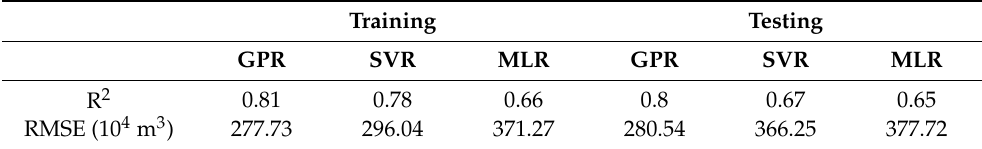
Table 7. Model results for